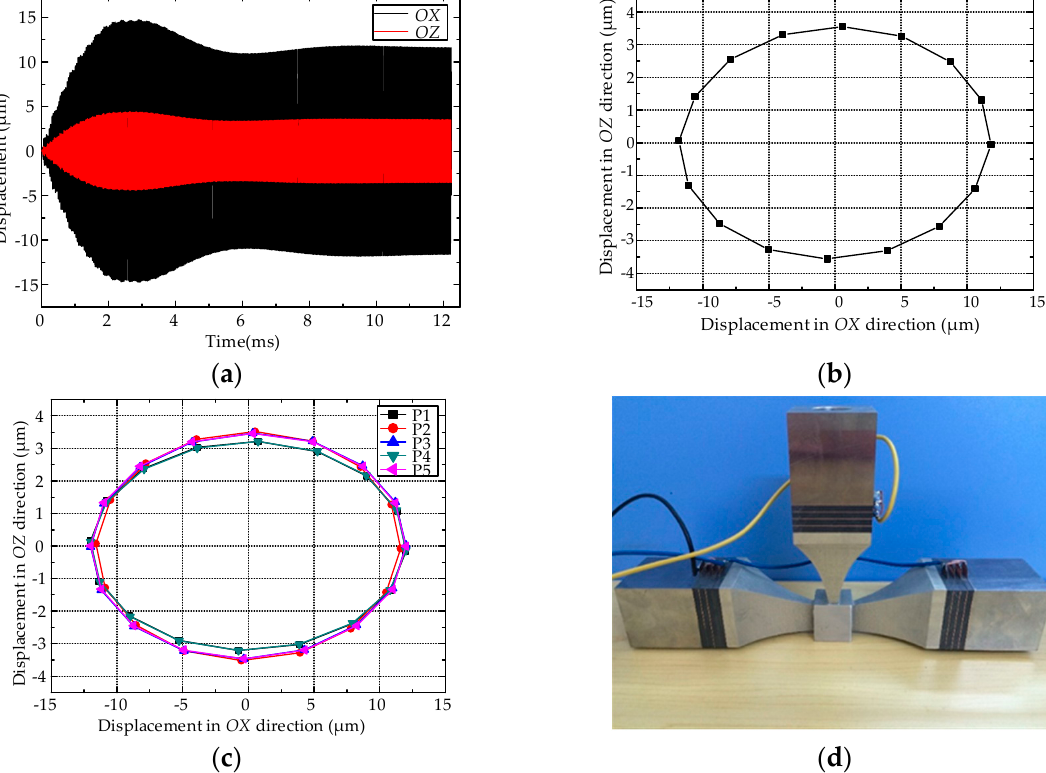
Figure 6. The elliptical trajectories and prototype of the stator: ( a ) The displacement response of the center point along OX , OZ direction; ( b ) The steady motion of the center point in XOZ plane; ( c ) The elliptical trajectories of driving foot; ( d ) The prototype of proposed motor.